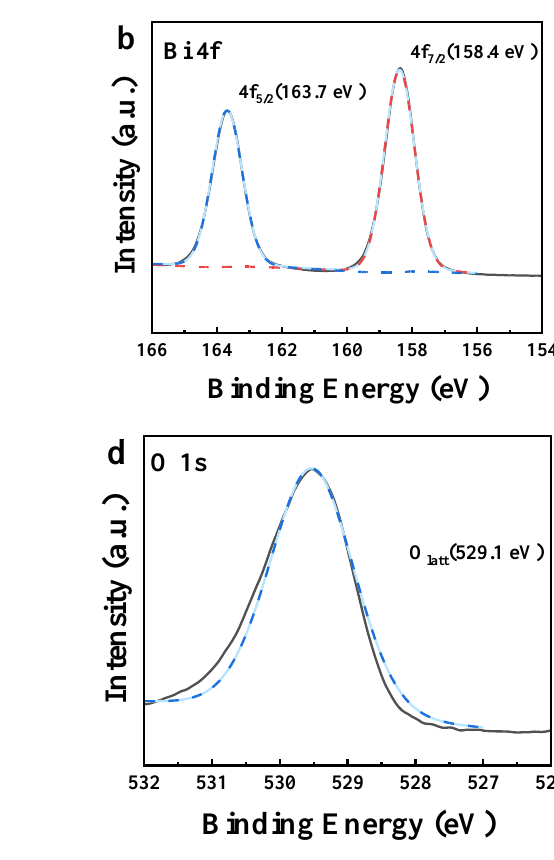
Figure 3. ( a ) XPS survey spectrum of BiVO 4 -7 and the corresponding high-resolution XPS spectra of ( b ) Bi 4f, ( c ) V 2p, and ( d ) O 1s. The two characteristic peaks at 523.5 eV and 516.0 eV correspond to V 2p1/2 and V 2p3/2, respectively (Figure 3c). The 7.5 eV spacing between the peaks of 2p1/2 and V 2p3/2 confirmed the +5 valence state of vanadium. The peak in the high-resolution